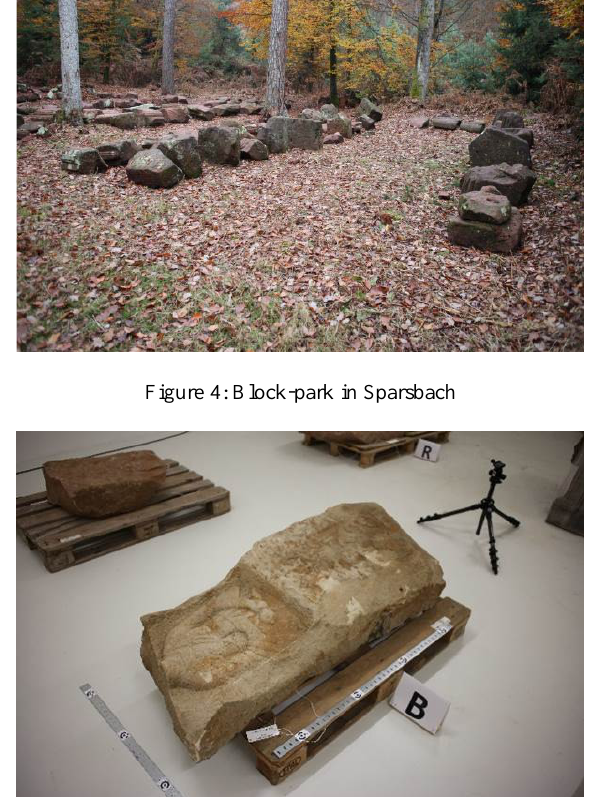
Figure 5: Acquisition environment for